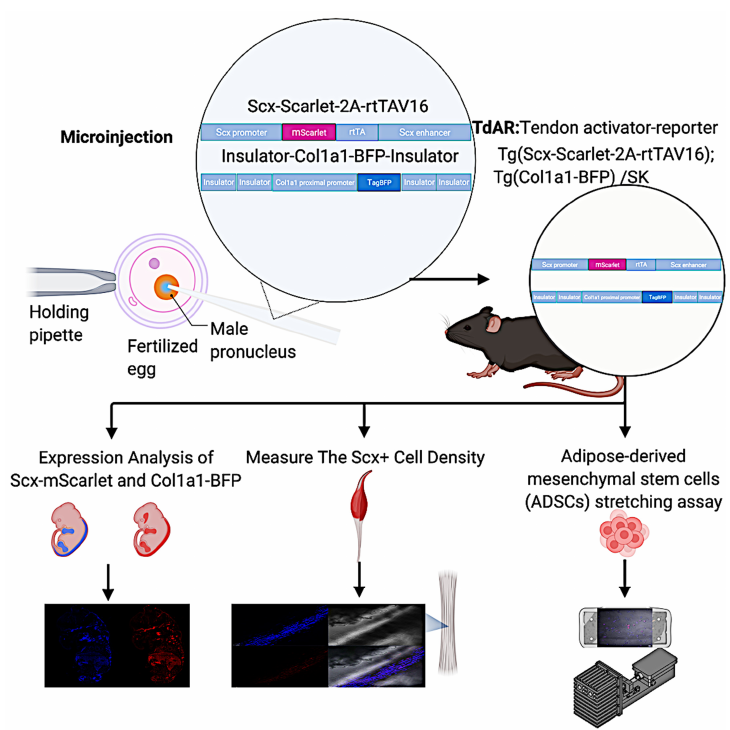
Figure 1. Scheme of this study. Tg ( Scx -Scarlet-2A-rtTAV16) Tg ( Col1a1 -BFP) /SK mouse line was obtained from pro-nuclear microinjection. Then we analyzed the Scx -mScarlet and Col1a1 -BFP expression in the whole-mounted embryo and cryosection. The Scx+ cell densities in the central region of the Achilles tendon from young and adult mice were measured using Fiji. Further, the adipose-derived mesenchymal stem cells (ADMSCs) stretching assay was performed in vitro. (This figure was created using BioRender.com.)